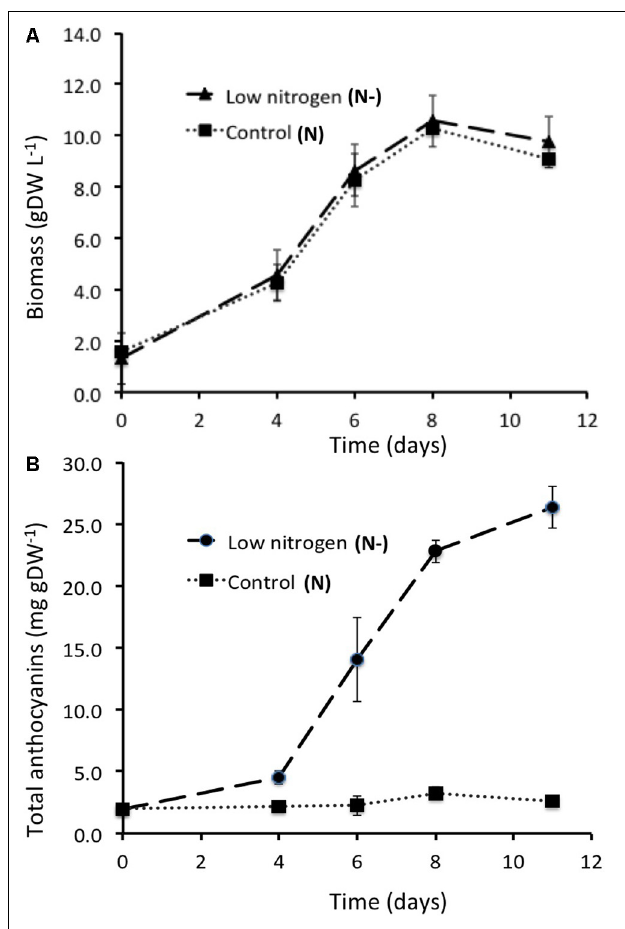
FIGURE 2 | Cell growth of the GT3 (A) and the anthocyanin production (B) in control and low nitrogen conditions (N, control, 25 mM KNO 3 and N–, nitrogen limitation, 5 mM KNO 3 , respectively). Data are the mean ± SE ( n = 3) (exp. 1 and exp. 2).